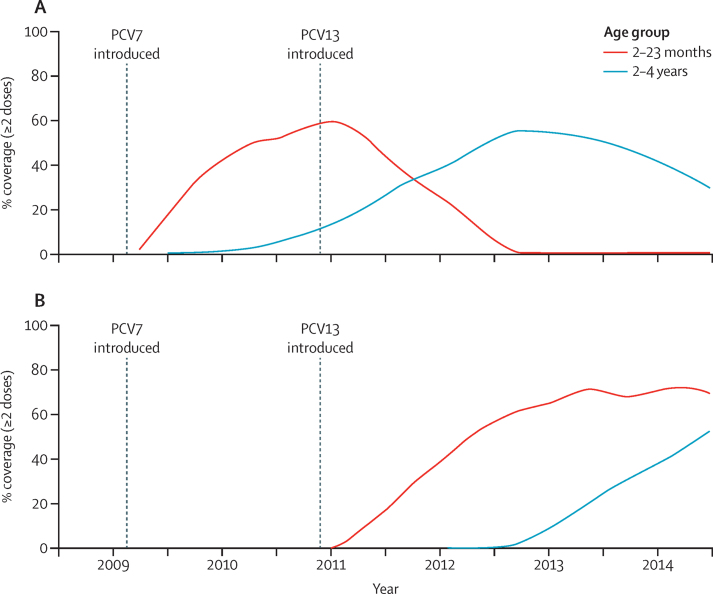
Vaccine coverageCoverage of two or more doses of (A) PCV7 and (B) PCV13, by age group over time.